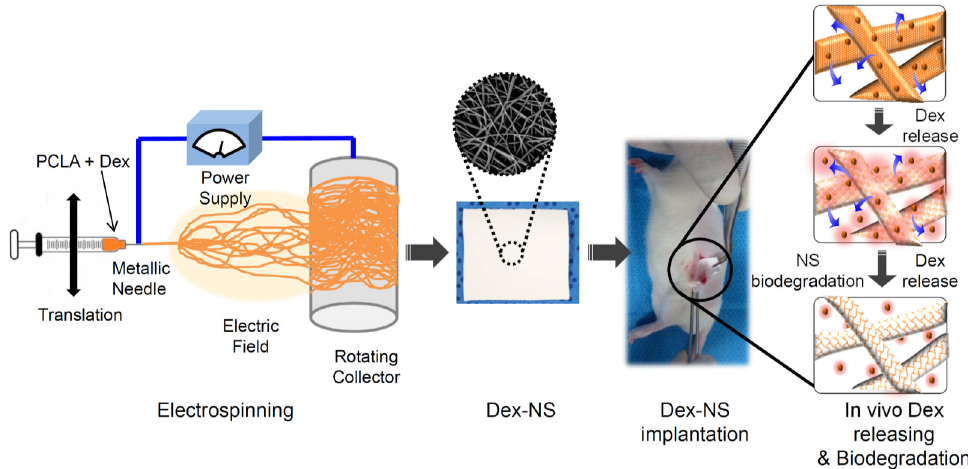
Figure 1. Schematic showing the experimental procedures of preparation, implantation, in vivo release and in vivo biodegradation of Dex ‐ NS.